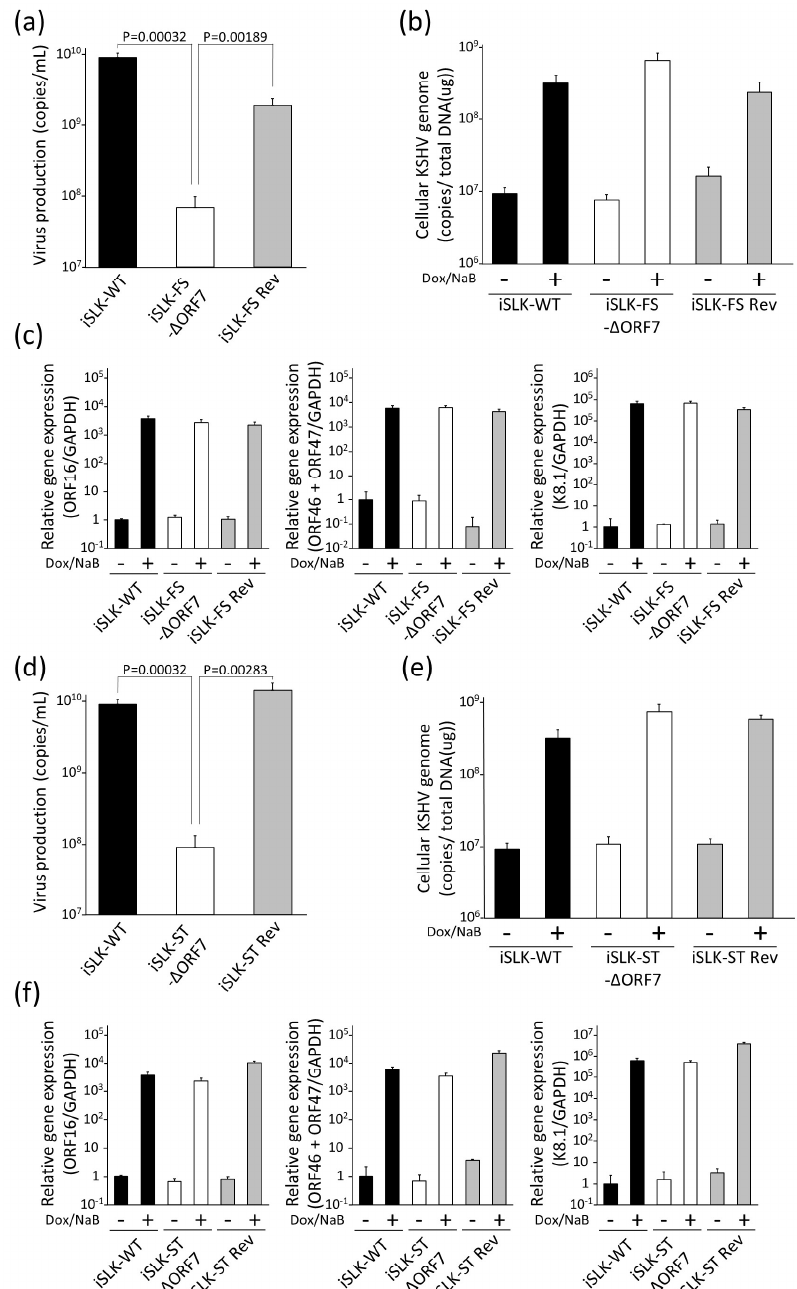
Figure 2. The effects of ORF7 deficiency on KSHV lytic replication. ( a – c ) Extracellular virus pro- duction and intracellular viral DNA replication and lytic gene expression in iSLK cells harboring WT-KSHV-BAC16, frameshift-induced ORF7-KSHV-BAC16, and revertant KSHV-BAC16. The iSLK- WT, iSLK-FS ∆ ORF7, and iSLK-FS Rev cell lines were cultured for 72 hours with medium containing Dox and NaB to induce lytic replication. ( a ) KSHV genome copies of packaged viral particles in culture supernatants were measured using real-time PCR. ( b ) The quantities of intracellular viral DNA of Dox- and NaB-treated iSLK cells were measured using real-time PCR and normalized by the total amount of DNA. ( c ) The quantities of mRNA expression levels of viral lytic genes: IE, ORF16 (vBcl-2); E, ORF46 (uracil DNA glycosylase) and ORF47 (glycoprotein L); L, K8.1 (glycoprotein) in lytic-induced iSLK-WT, iSLK-FS ∆ ORF7, and iSLK-FS Rev cell lines. Each iSLK cell line was treated with or without 8 µ g/mL Dox and 1.5 mM NaB, and cells were harvested at 72 h post-treatment. Total RNA purified from cells was subjected to RT real-time PCR. Evaluated lytic genes were